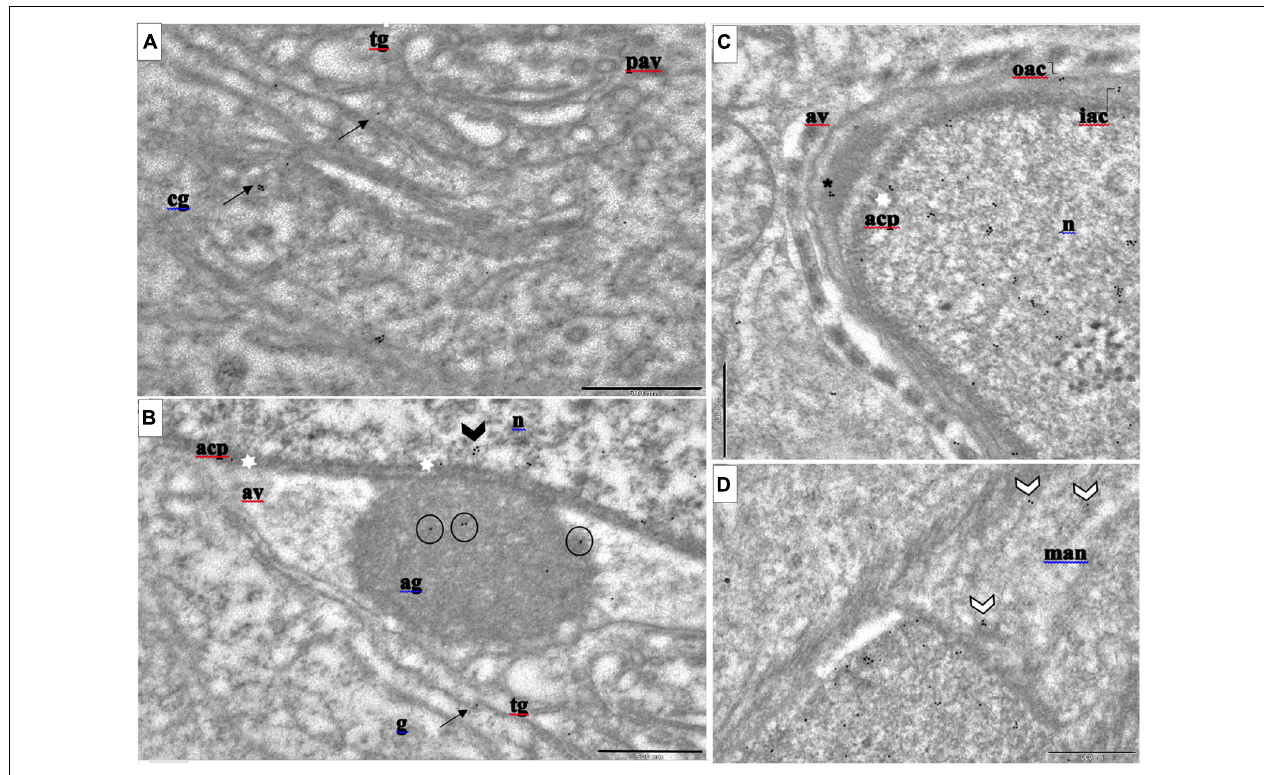
FIGURE 1 | Immunogold labeling of PFN3 in developing mouse spermatid during acrosome biogenesis. (A) cis - and trans- Golgi network; immunogold particles in cg and tg = black arrows. (B) Golgi phase; immunogold labeling highlighted in ag = circles, acp = white stars, and n = arrow head. (C) Cap phase; immunogold particles highlighted in av = asterisk. (D) Man immunogold labeling = white arrow heads. cg, cis-Golgi; tg, trans-Golgi; ag, acrosomal granule; n, nucleus; acp, acroplaxome; av, acrosomal vesicle. Scale bar = 500 nm. (A,B) are from the same image (ref.to Supplementary Figure 2A